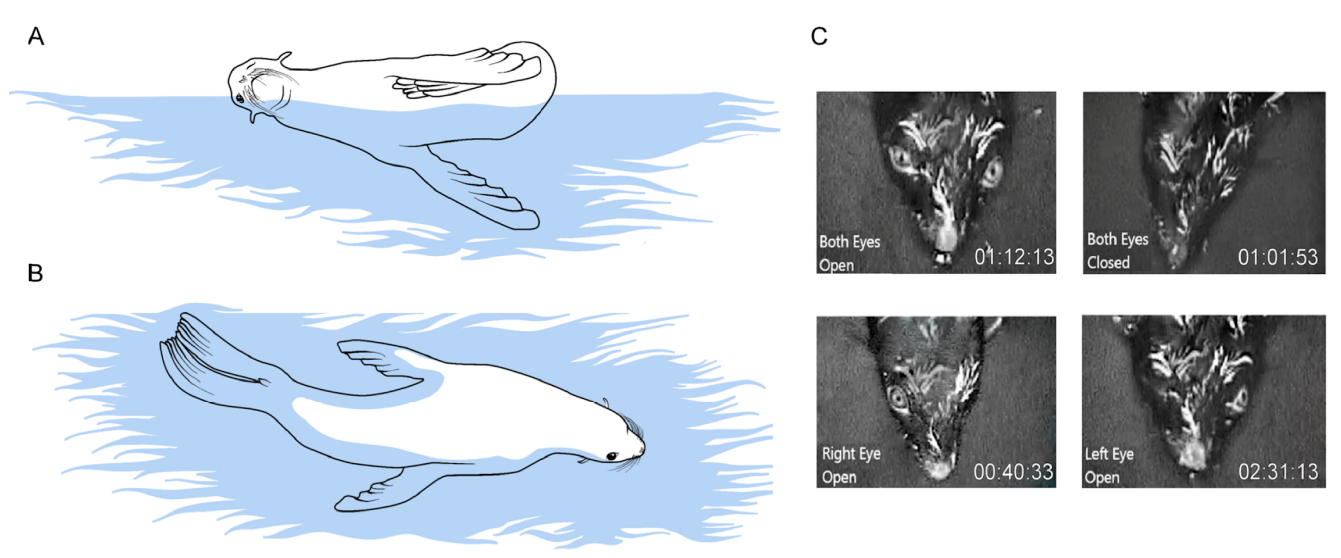
Fig 1. Sleep postures and eye states in fur seals in water. Fur seals sleep in water at the surface in the lateral and prone positions. (A) During USWS in the lateral position, the “waking” hemisphere is contralateral to the moving flipper, while the “sleeping” hemisphere is ipsilateral to the moving flipper. When in this position, the fur seal’s eye which is directed to the sky (contralateral to the sleeping hemisphere) is often closed, while the eye facing the water (contralateral to the waking hemisphere) is usually not visible. (B) When the fur seal sleeps in the prone position, both eyes are visible most of the time and the motion is minimal. (C) Symmetrical and asymmetrical eye state in a fur seal resting in water in a prone